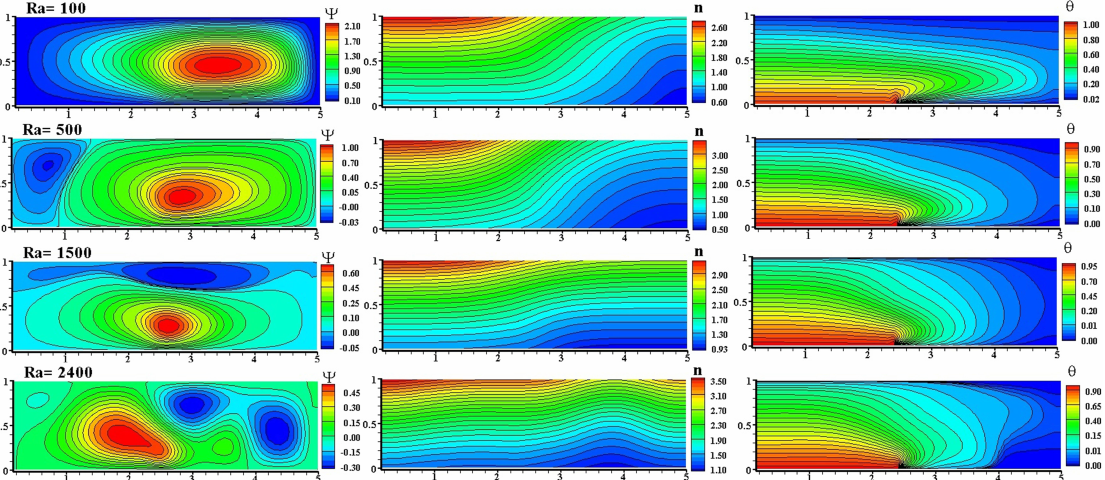
Figure 3. Case 1. From left to right, streamlines, microorganisms concentration and dimensionless temperature contours. For Sc = 1, Pe = 1, Ra T = 1708 and bioconvective Ra for 100, 500, 1500 and 2400.